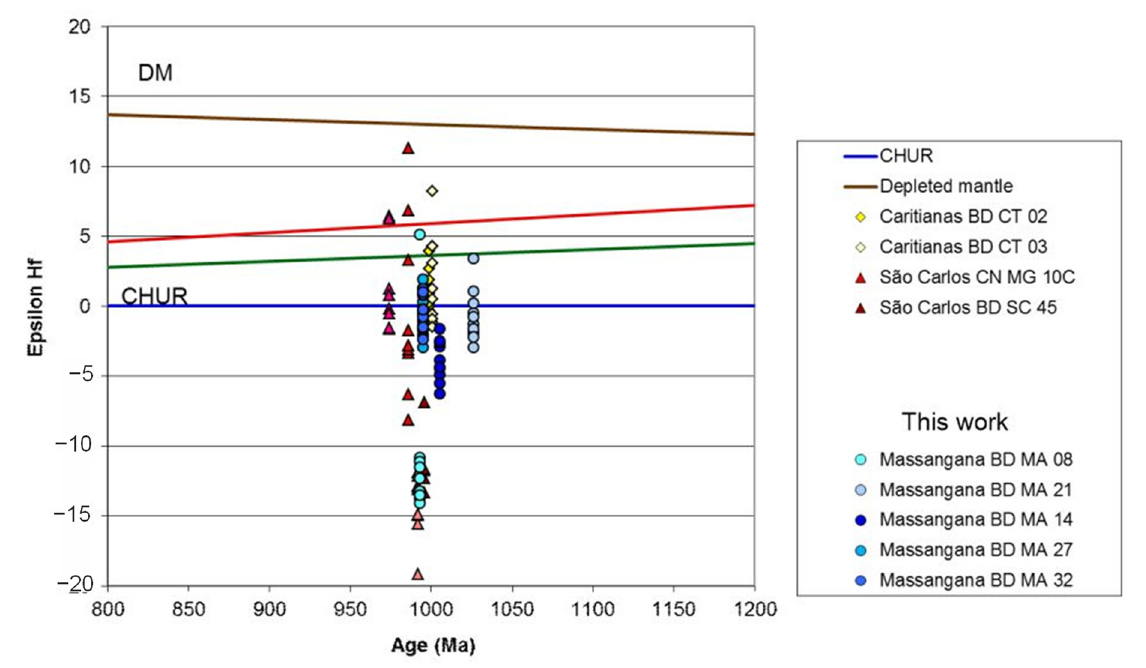
Figure 19. Diagram of the isotopic evolution of Hf for the granitic samples of the Rondônia Tin Province. The granitic samples show groups with Hf model ages indicative of periods of mantle extractions. The results show mantle and crustal sources for each magmatic pulse in forming magmas generating the intrusive suites.